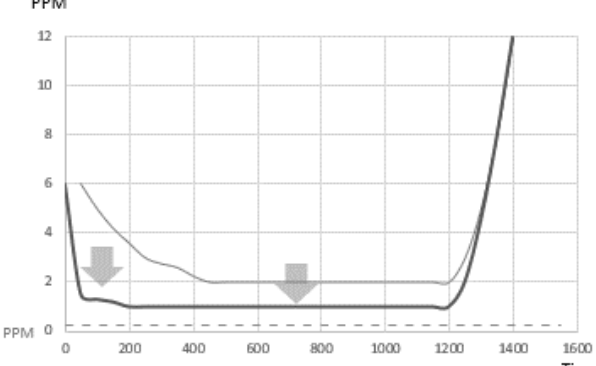
Figure 3. Pushing down the bathtub diagram.